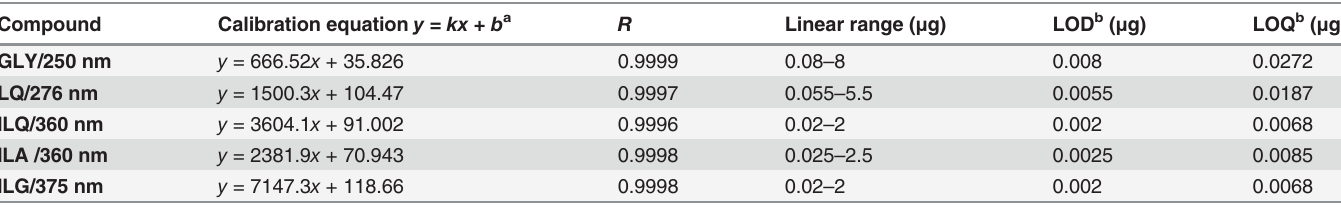
Table 3. Calibration plots, LOD and LOQ for the 5